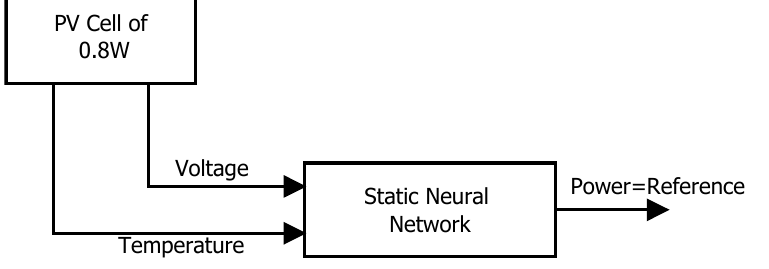
Figure 15. Neurocontroller reference signal.